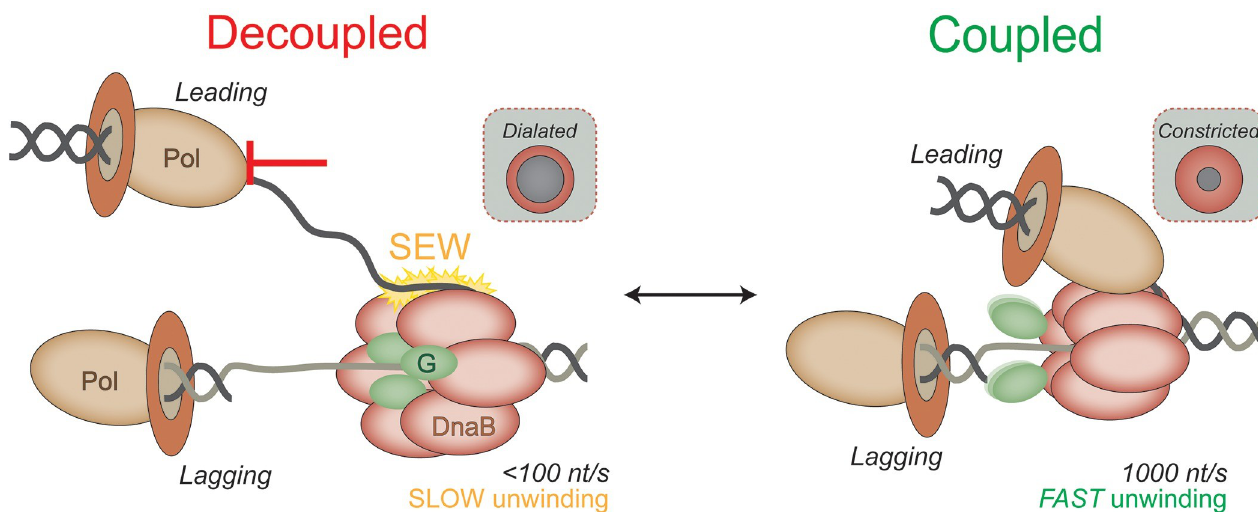
Fig 9. Model for helicase-polymerase decoupling leading to genomic instability. DnaB unwinding is rapid when coupled tightly within the replisome. Upon encountering various obstacles to DNA synthesis, DnaB adopts a dilated conformation and interacts with the excess excluded strand to slow the unwinding rate and limit production of ssDNA, allowing the polymerase (Pol) to couple with DnaB. DnaG (green) is more tightly associated with a dilated DnaB. DnaB mutants resist conformational switching to the dilated state and maintain accelerated unwinding, increasing the amount of labile ssDNA produced causing genome